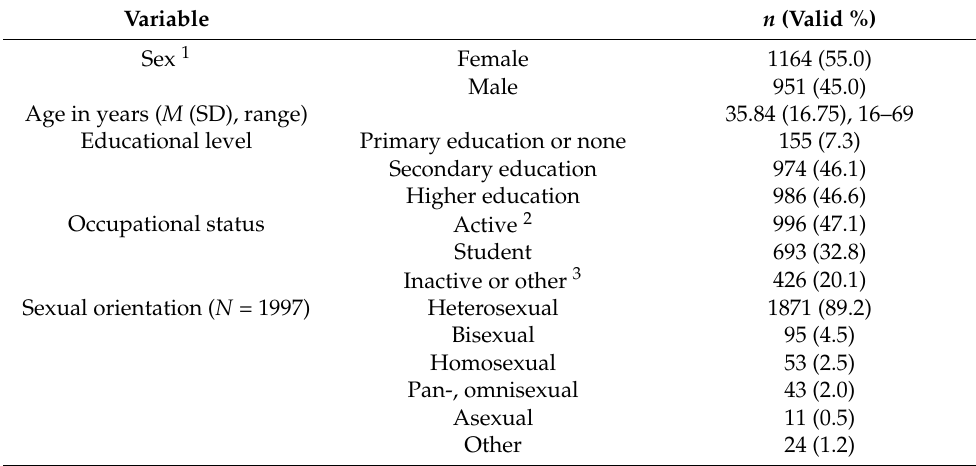
Table 1. Sample composition ( n = 2115), unweighted.